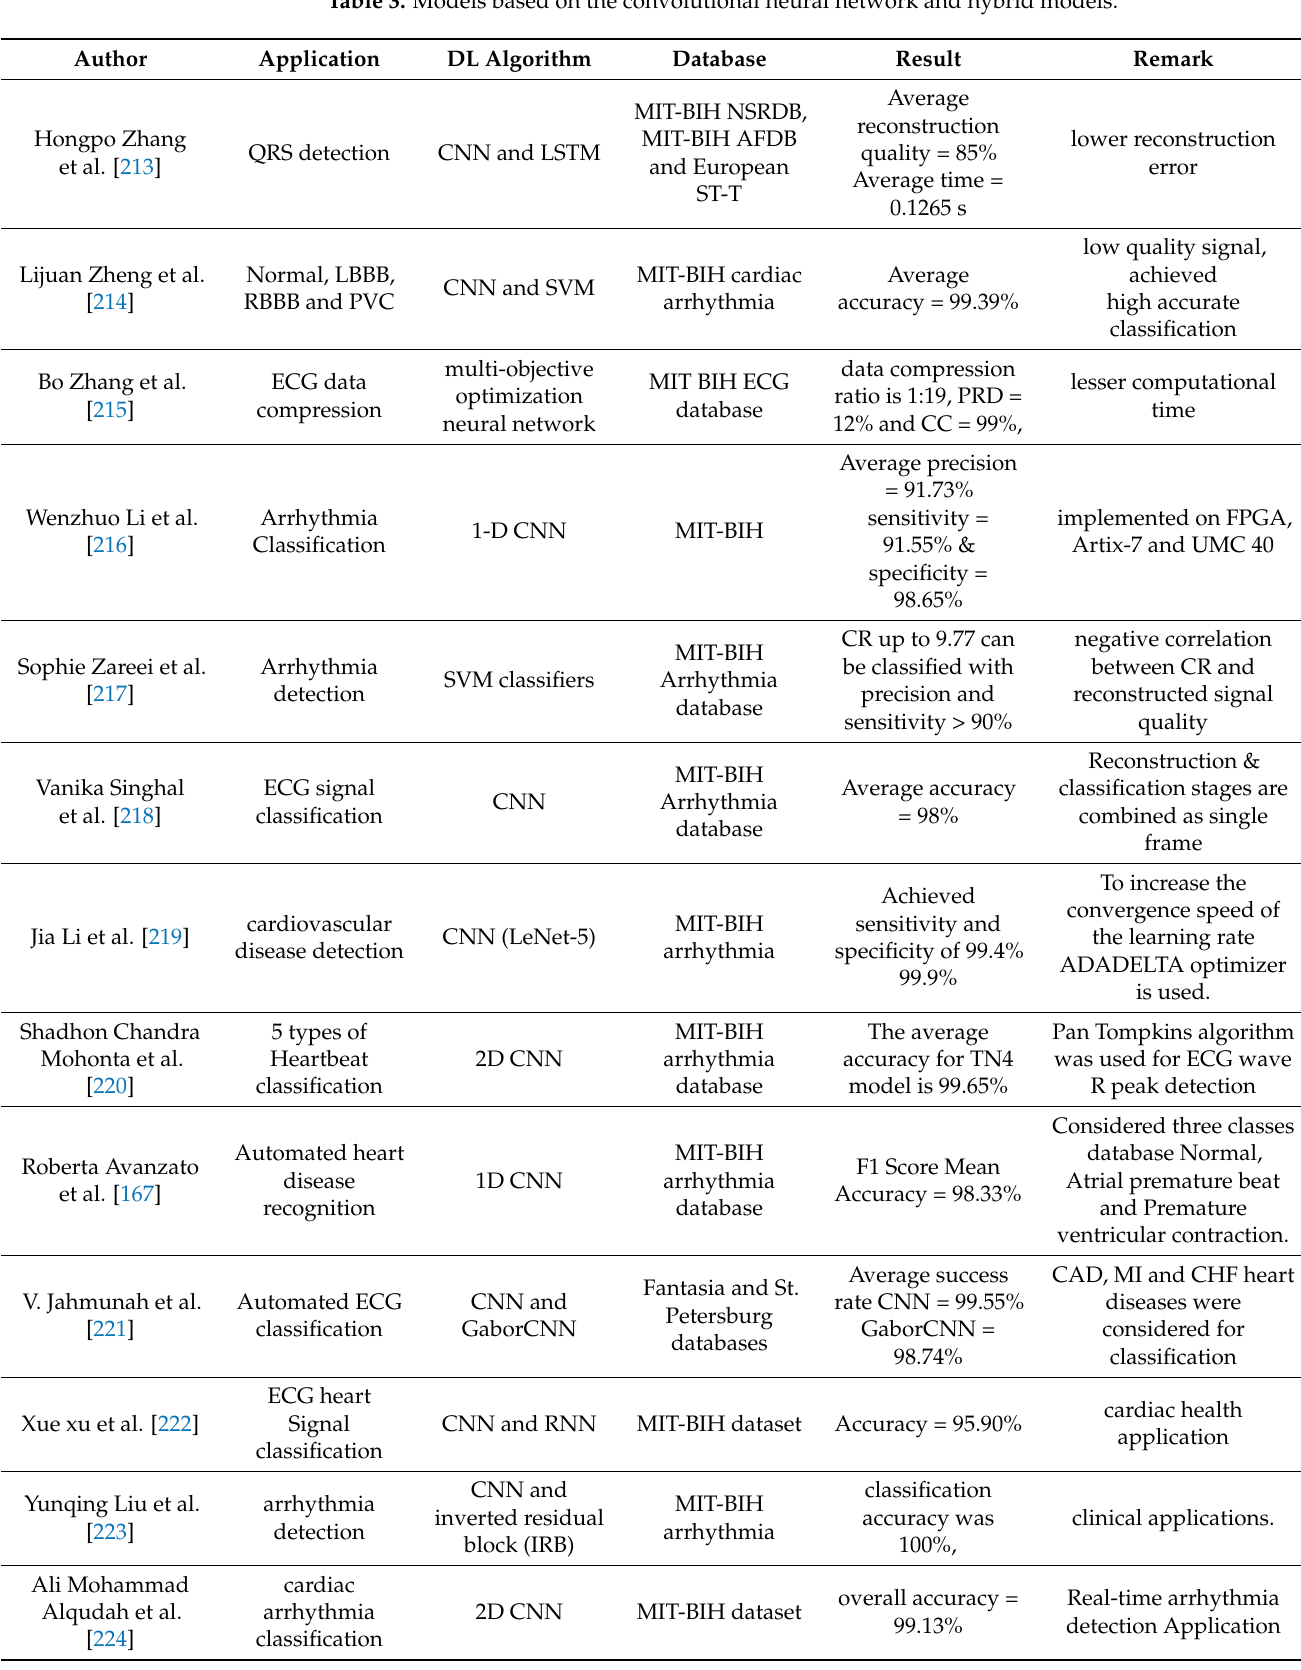
Table 3. Models based on the convolutional neural network and hybrid